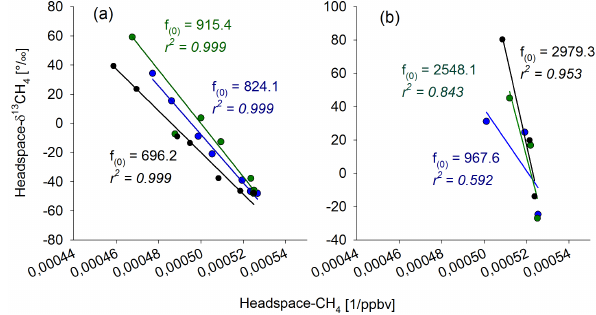
Figure 3. Keeling plots for the treatment (a) algae + 13 C-Bic and (b) algae + 13 C-Met, where f ( 0 ) refers to the 13 C value of the CH 4